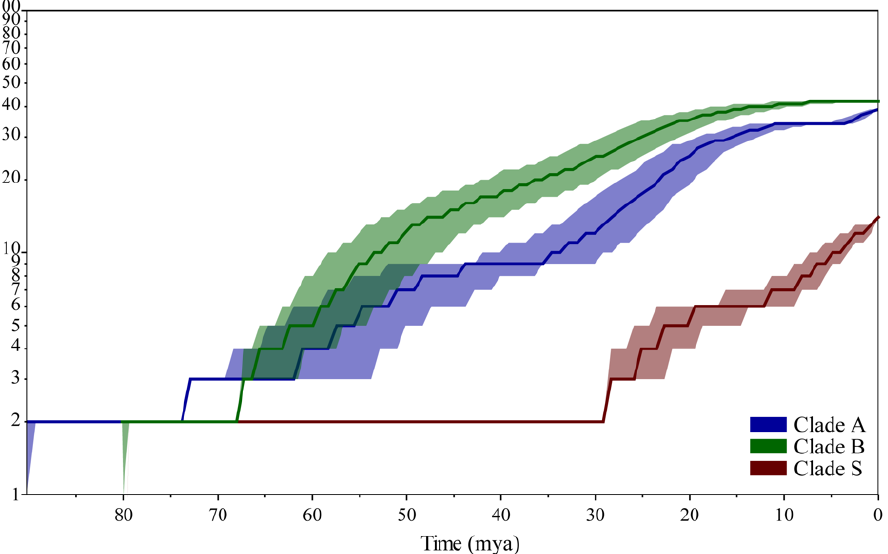
Figure 4. Temporal patterns of linyphiid lineage diversifications. a, stepped line in color indicate species number of lineages vary through time for Solenysa clade (brown), clade A (purple), and clade B (green). The shadowed areas in the same color show 95% confidence intervals.